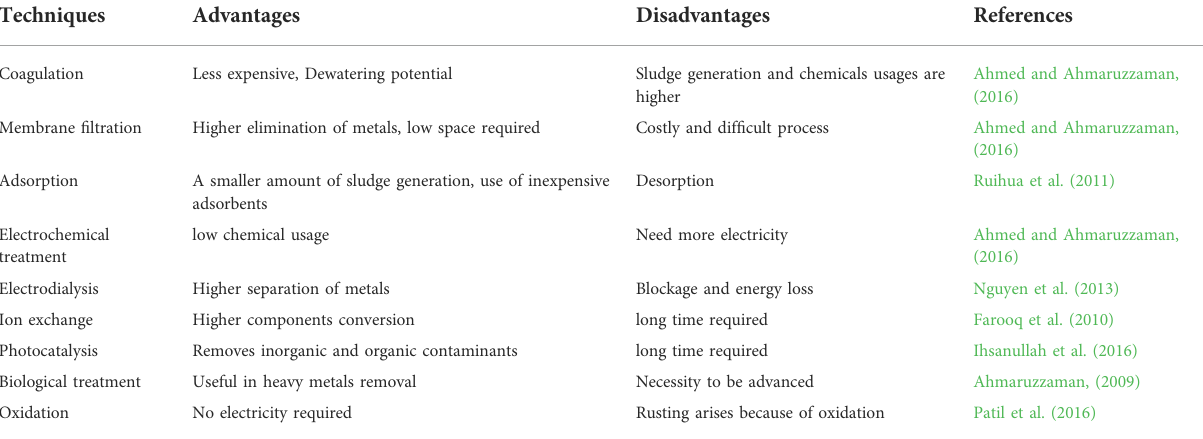
TABLE 3 Merits and demerits of clean-up technologies for Metal